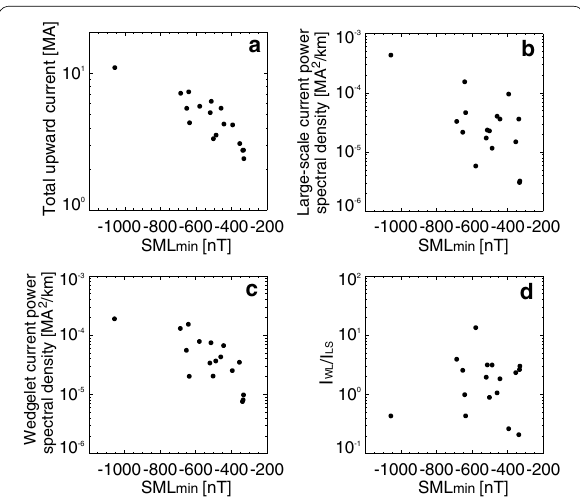
Fig. 5 a Maximum total upward current, b I LS , c I WL , and d I WL / I LS as a function of the minimum SML for individual